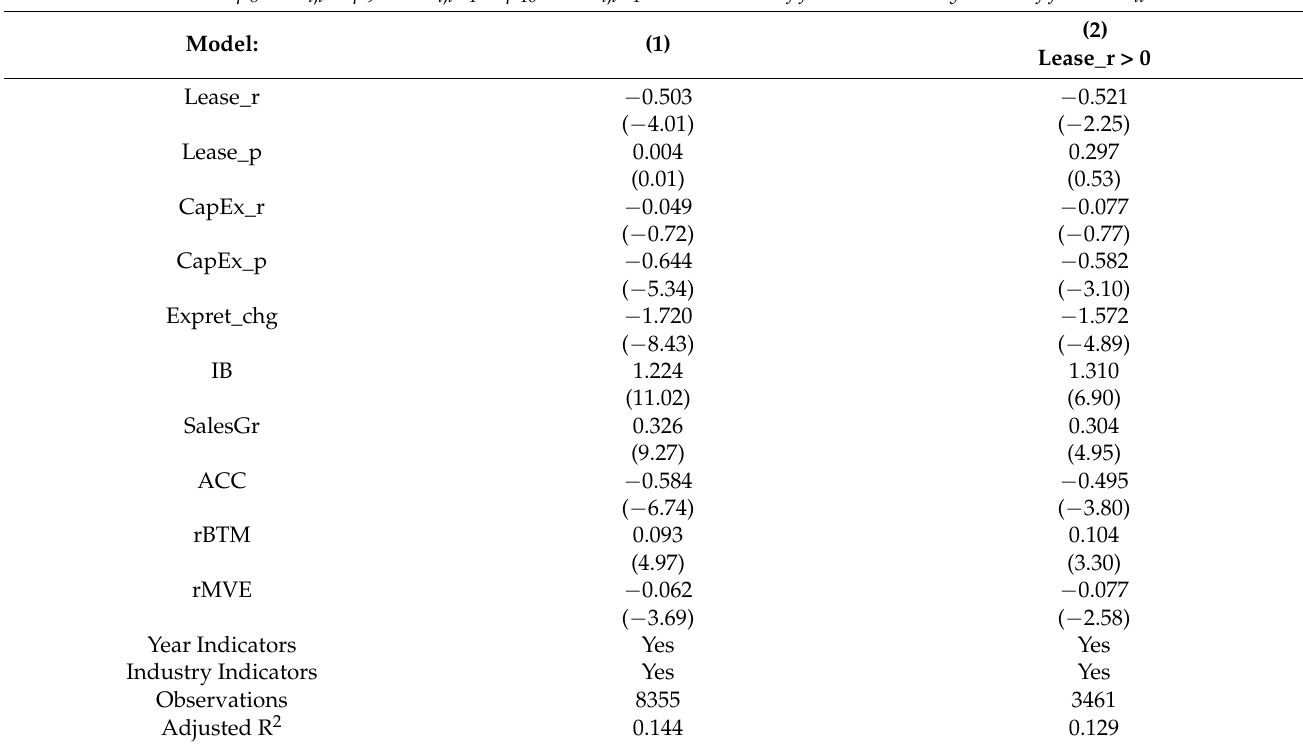
Table 9. Tests of the Association between Leases and Contemporaneous Stock Returns. CSAR i ,